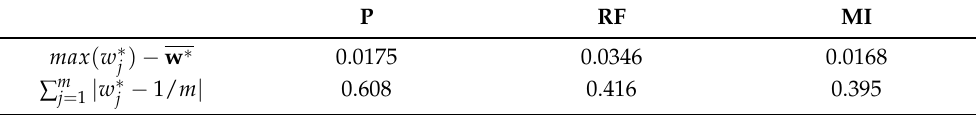
Table 7. Difference between the maximum and the mean weight values for each FW method.